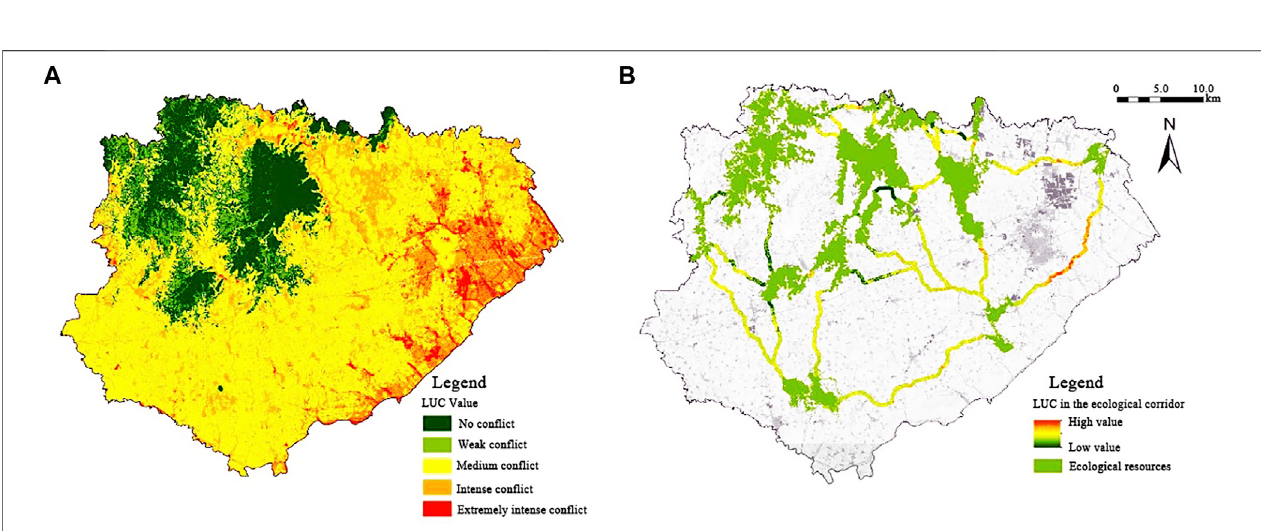
FIGURE 5 | LUC in Quanjiao County and ecological corridors. (a. LUC in overall area of Quanjiao County; b. LUC in ecological corridors of Quanjiao County.)